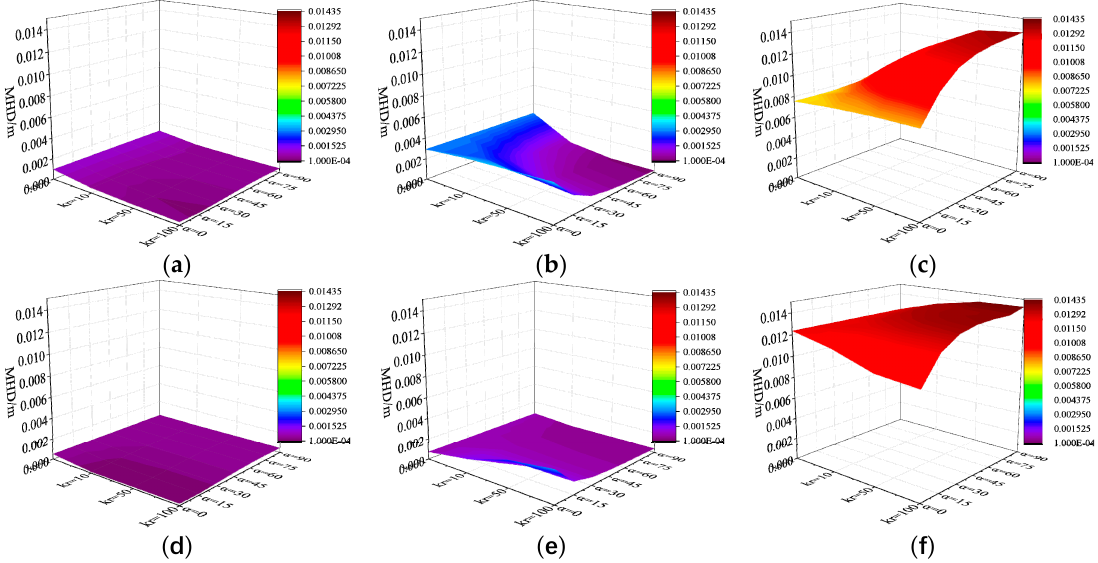
Figure 10. Variations of maximum horizontal displacement (MHD) under different k r and α values. ( a ) Top of the sandy slope. ( b ) Middle of the sandy slope. ( c ) Toe of the sandy slope. ( d ) Top of the clay slope. ( e ) Middle of the clay slope. ( f ) Toe of the clay slope.